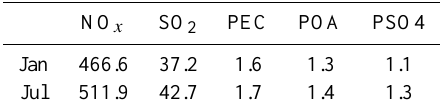
Table 5. Monthly total aircraft emissions (short tons) in January (Jan) and July (Jul) of NO x and SO 2 (inorganic PM precursors) and primary elemental carbon (PEC), organic carbon (POA), and sulfate (PSO4). NO x SO 2 PEC POA PSO4